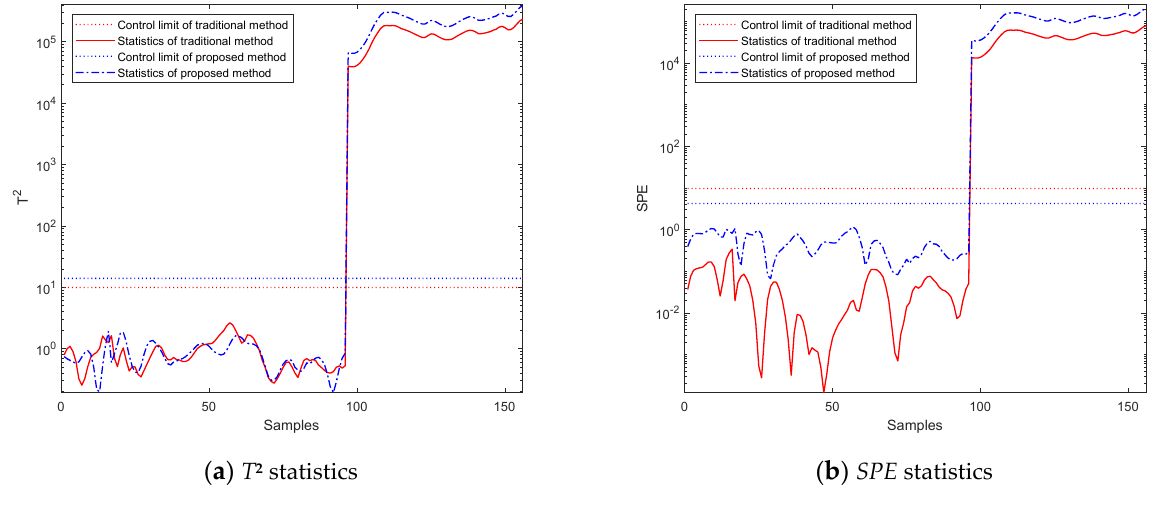
Figure 9. Online monitoring of the sensor fault.